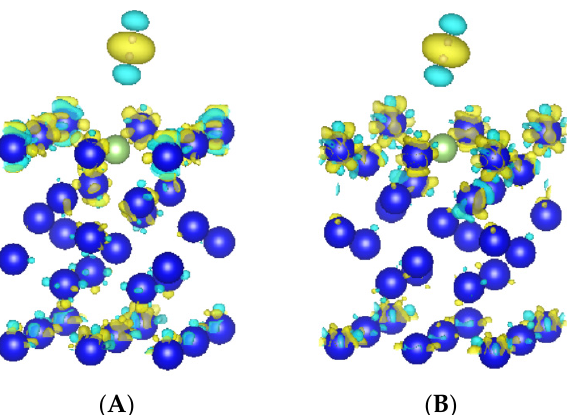
Figure 4. Differential charge density of H-t-hor and H-b-ver configurations. ( A ) H-h-hor1. ( B ) H-b-ver. Note: The electron density equivalent surface is 6 e/nm 3 ; yellow indicates an increase in charge density, and gray indicates a decrease in charge density.